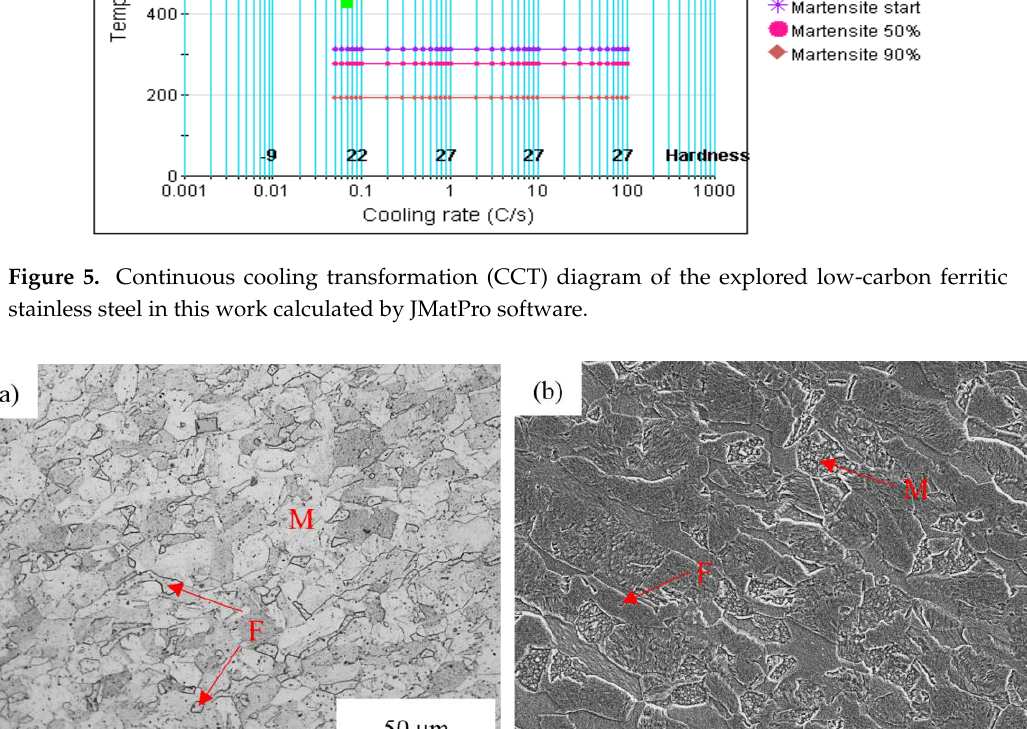
Figure 6. Microstructure of the low-carbon ferritic stainless steel sample after austenitization: ( a ) optical micrograph, ( b ) SEM micrograph.